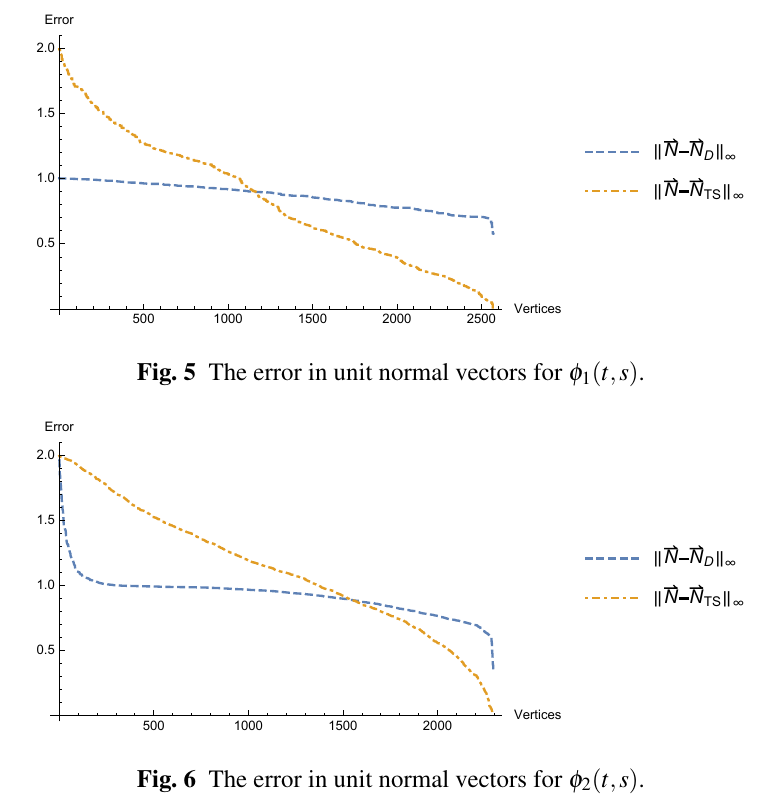
Fig. 6 The error in unit normal vectors for φ 2 ( t , s ) .